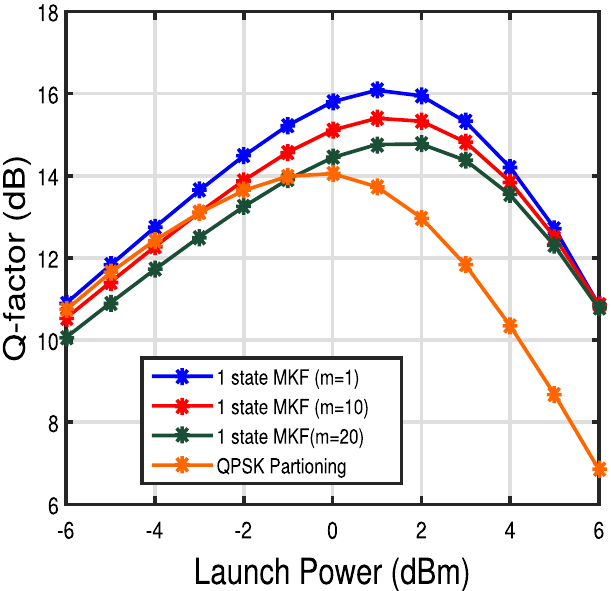
100 kHz and 12 spans for different =